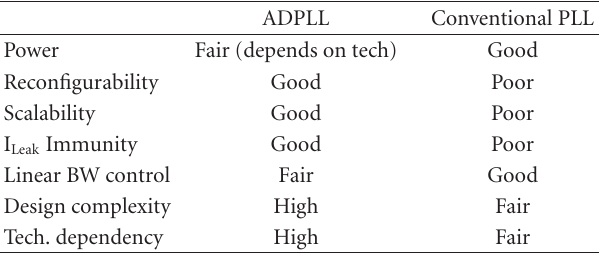
Table 1: ADPLL versus conventional